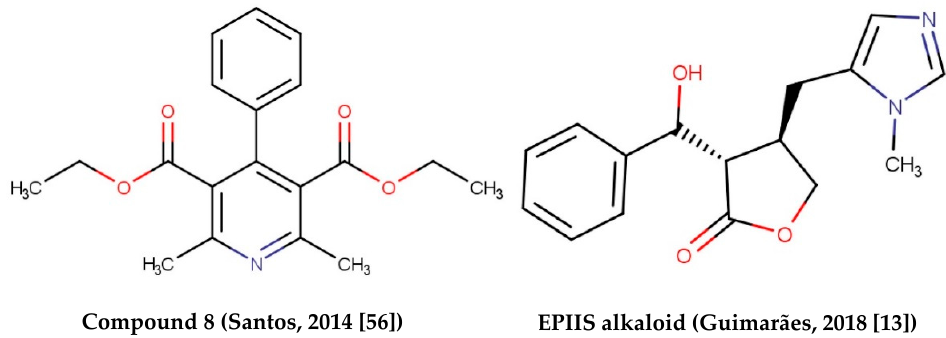
Figure 5. Alkaloids with schistosomicidal activity found in the literature.